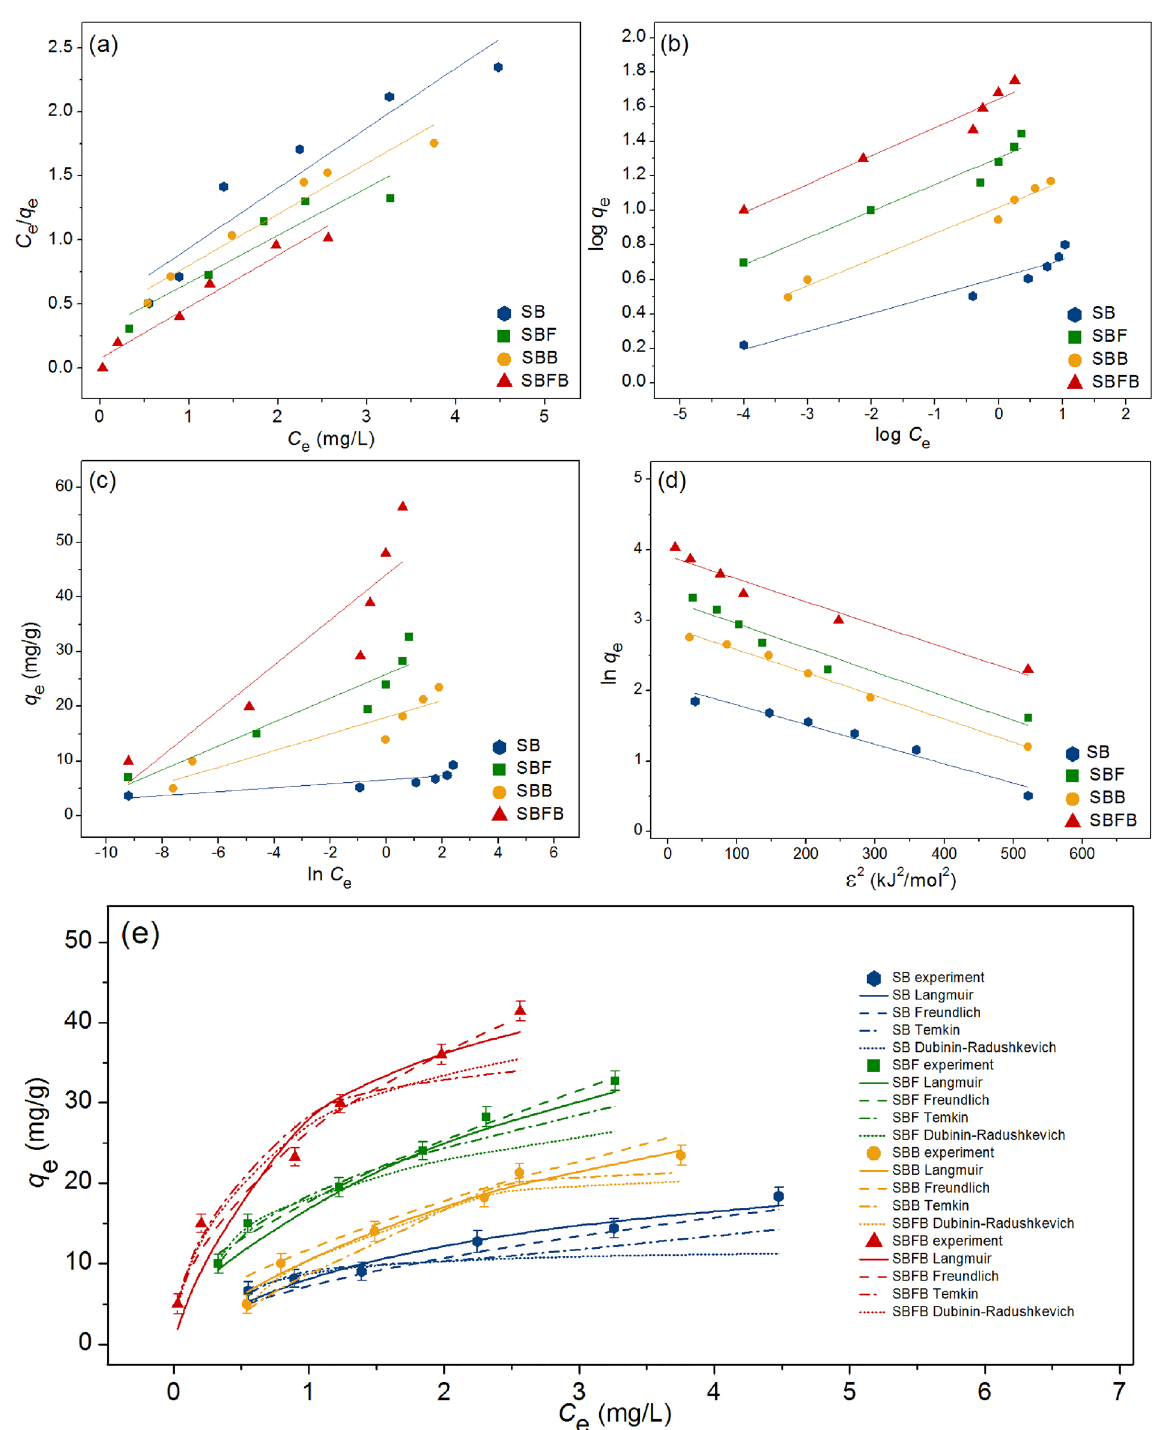
Figure 7. Graphs of ( a ) linear Langmuir, ( b ) linear Freundlich, ( c ) linear Temkin, ( d ) linear Dubinin– Radushkevich, and ( e ) nonlinear adsorption isotherms of sugarcane bagasse powder (SB), sugarcane bagasse powder doped iron(III) oxide-hydroxide (SBF), sugarcane bagasse powder beads (SBB), and sugarcane bagasse powder doped iron(III) oxide-hydroxide beads (SBFB) for lead